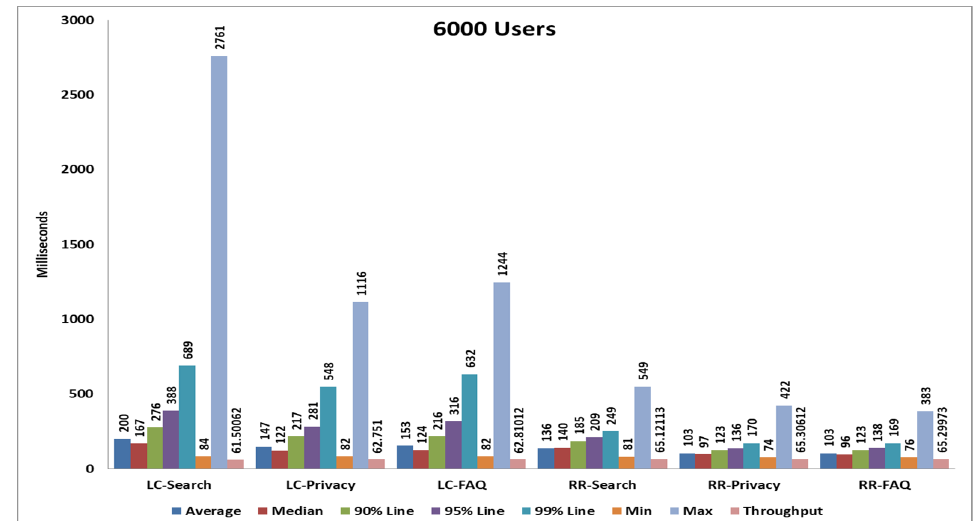
Figure 18. Aggregate graph using Table 6 data, showing the average response time, median, 90%, 95%, 99%, min & max parameter of the combined graphs of the RR and LC algorithms of Table 5.